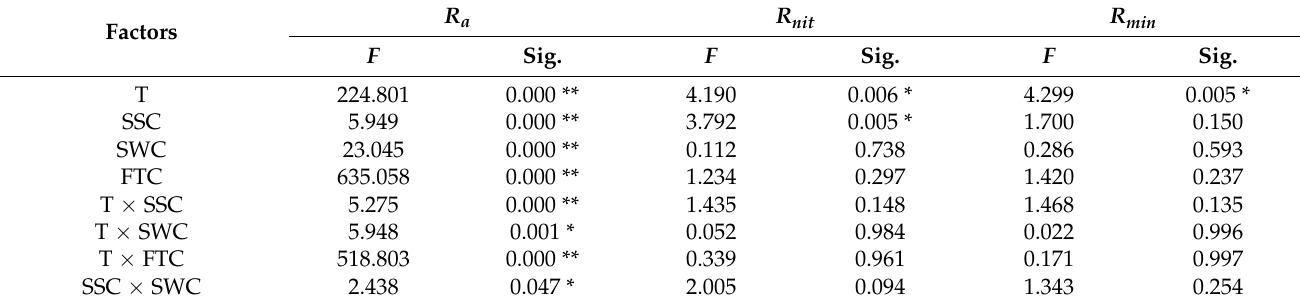
soil salt content; SWC: soil water content; FTC: number of freezing–thawing cycles; R a : net